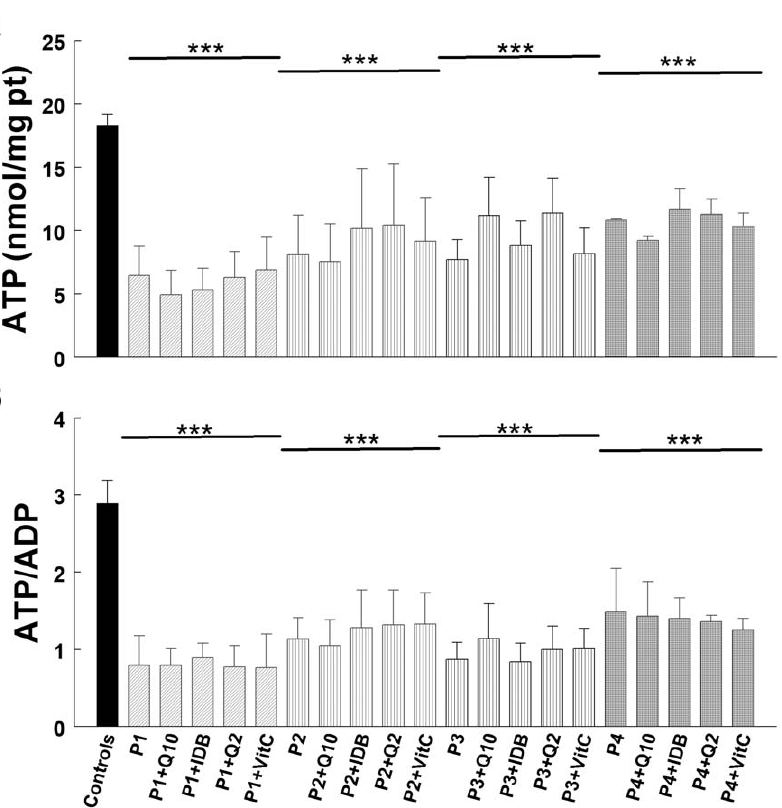
Figure 3. Bioenergetic status of cells after 24 hours of treatment. Cultured skin fibroblasts from controls and CoQ 10 deficient patients were treated with 5 m M CoQ 10 , idebenone, CoQ 2 , or vitamin C. After 24 h, fibroblasts were collected and cellular ATP and ADP were determined by UV- HPLC. Data are represented as nmol of ATP/mg prot ( A ) and ATP/ADP ratio ( B ). Results are expressed as mean 6 SD of three experiments. P1= COQ9 mutant; P2= COQ2 mutant; P3= COQ2 mutant; P4= PDSS2 mutant. *** P , 0.001 compared with untreated control.